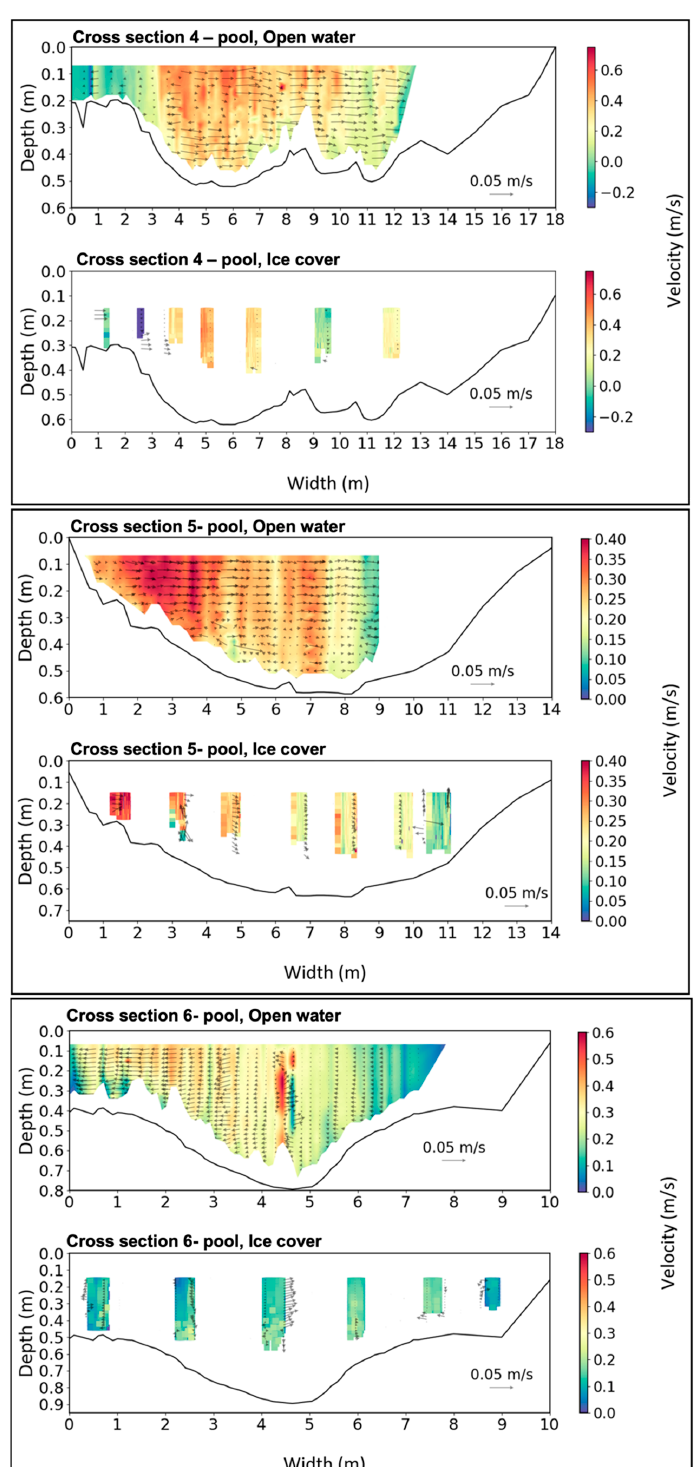
Figure 3. Velocity distribution maps along cross-section 4 ( upper panel ), 5 ( middle panel ) and 6 ( lower panel ) within the pool of the study site (Figure 1), from left bank to right bank under open-water conditions (top panel) and ice-covered conditions (bottom panel). Streamwise velocities are represented on a color scale and secondary velocities are represented by arrows showing direction and magnitude of the transverse and vertical velocity component. Data were collected using a Sontek S5 ADCP under ice-covered conditions on 23 February 2021, and open-water conditions on 2 March